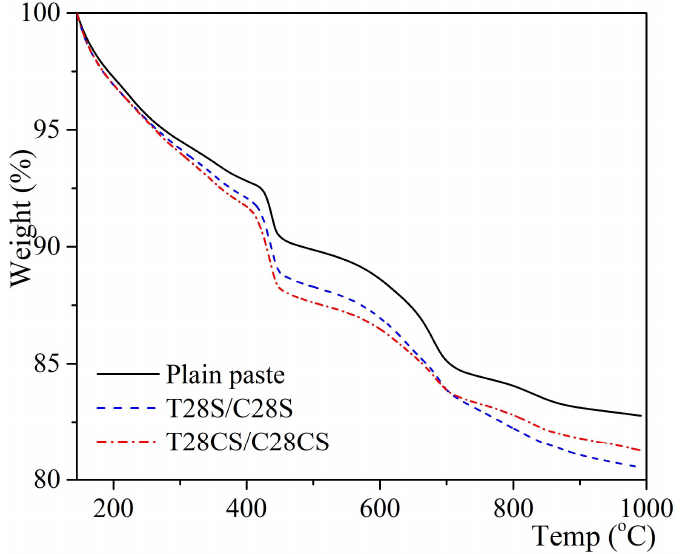
Figure 15. TGA results comparison of three samples.